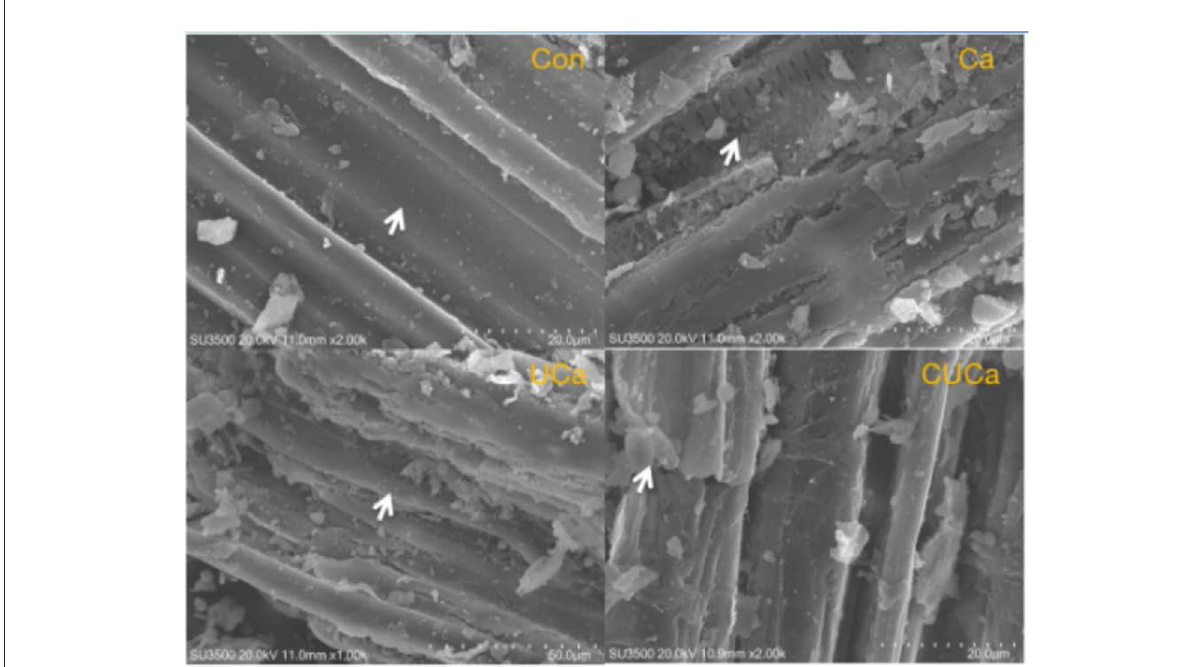
FIGURE4 SEM imagines of biomass residues obtained from pretreatment with CSL plus urea-alkali. Con: no pretreatment for control group, Ca: 4% CaO, UCa: 2.5% urea + 4% CaO, CUCa: 9% CSL + 2.5% urea + 4% CaO. Sample (Ca, UCa, CUCa) showing a coarse surface indicated as arrow, and sample Con displaying a flat